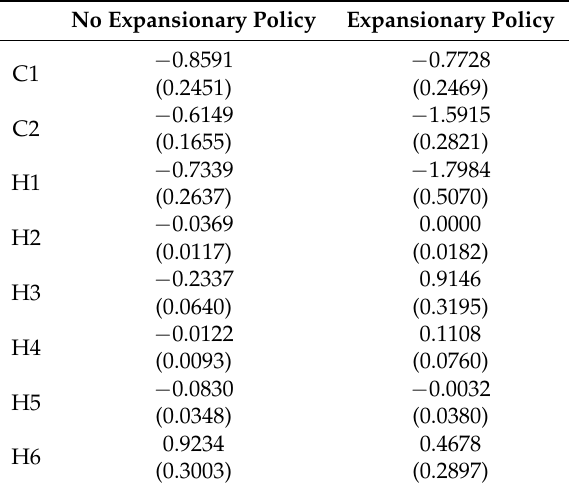
Table 3. Effects of FSI shock on household